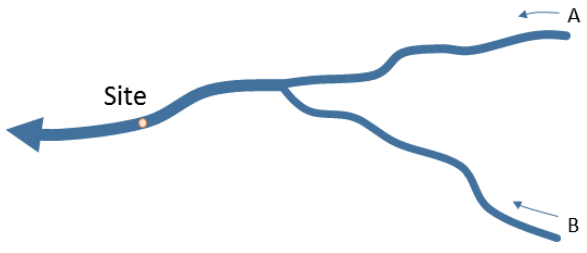
Figure 3. Schematic river system with single confluence.